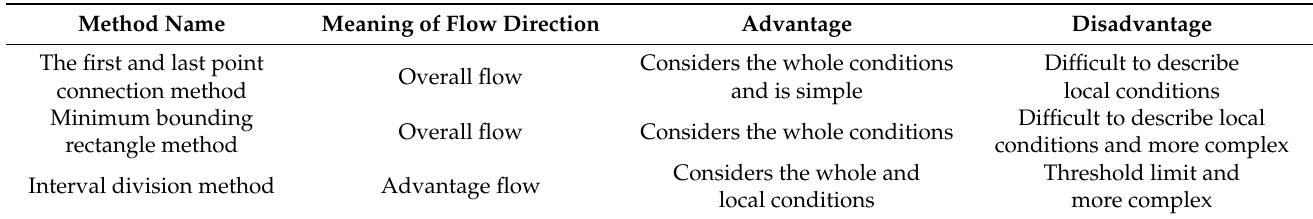
Table 1. Comparison of calculation methods for flow directions.